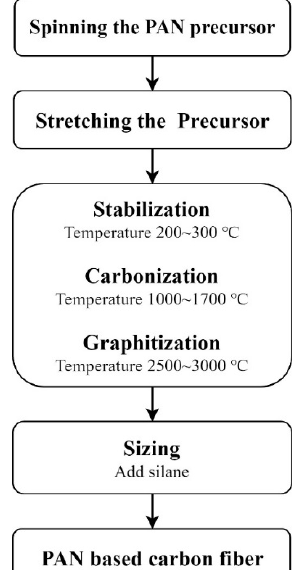
Figure 1. High-performance, polyacrylonitrile (PAN)-based carbon fiber production process [26].